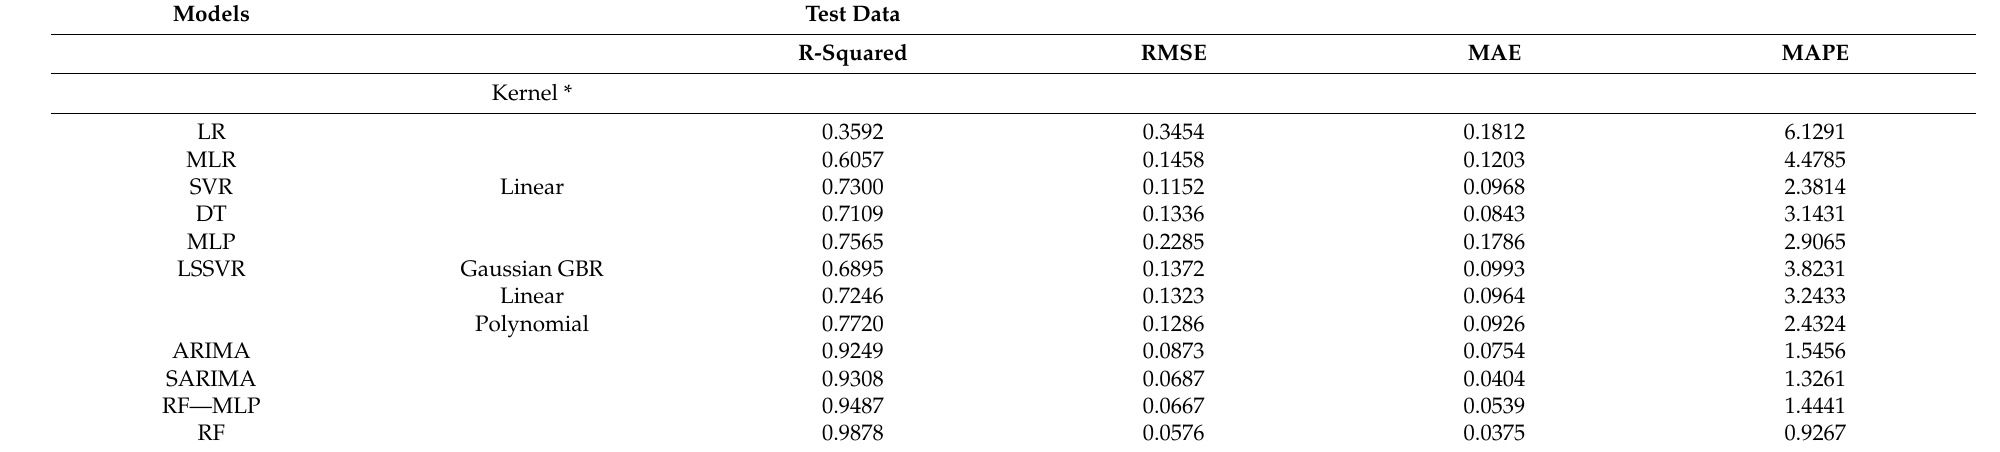
Table 4. Comparison of prediction accuracy with competing benchmark